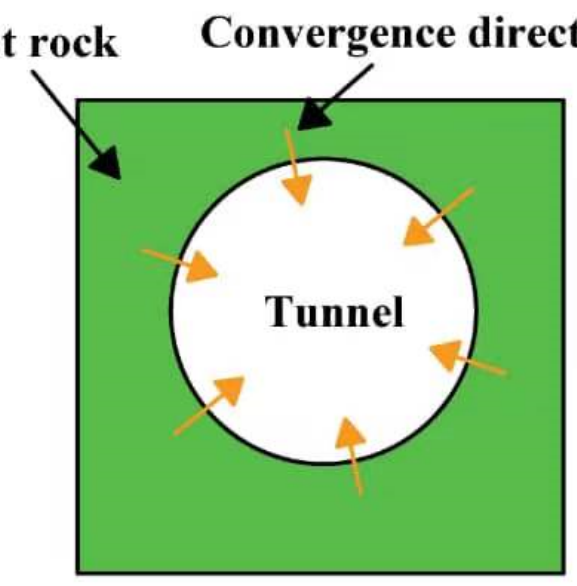
Figure 10. Illustration of tunnel convergence.